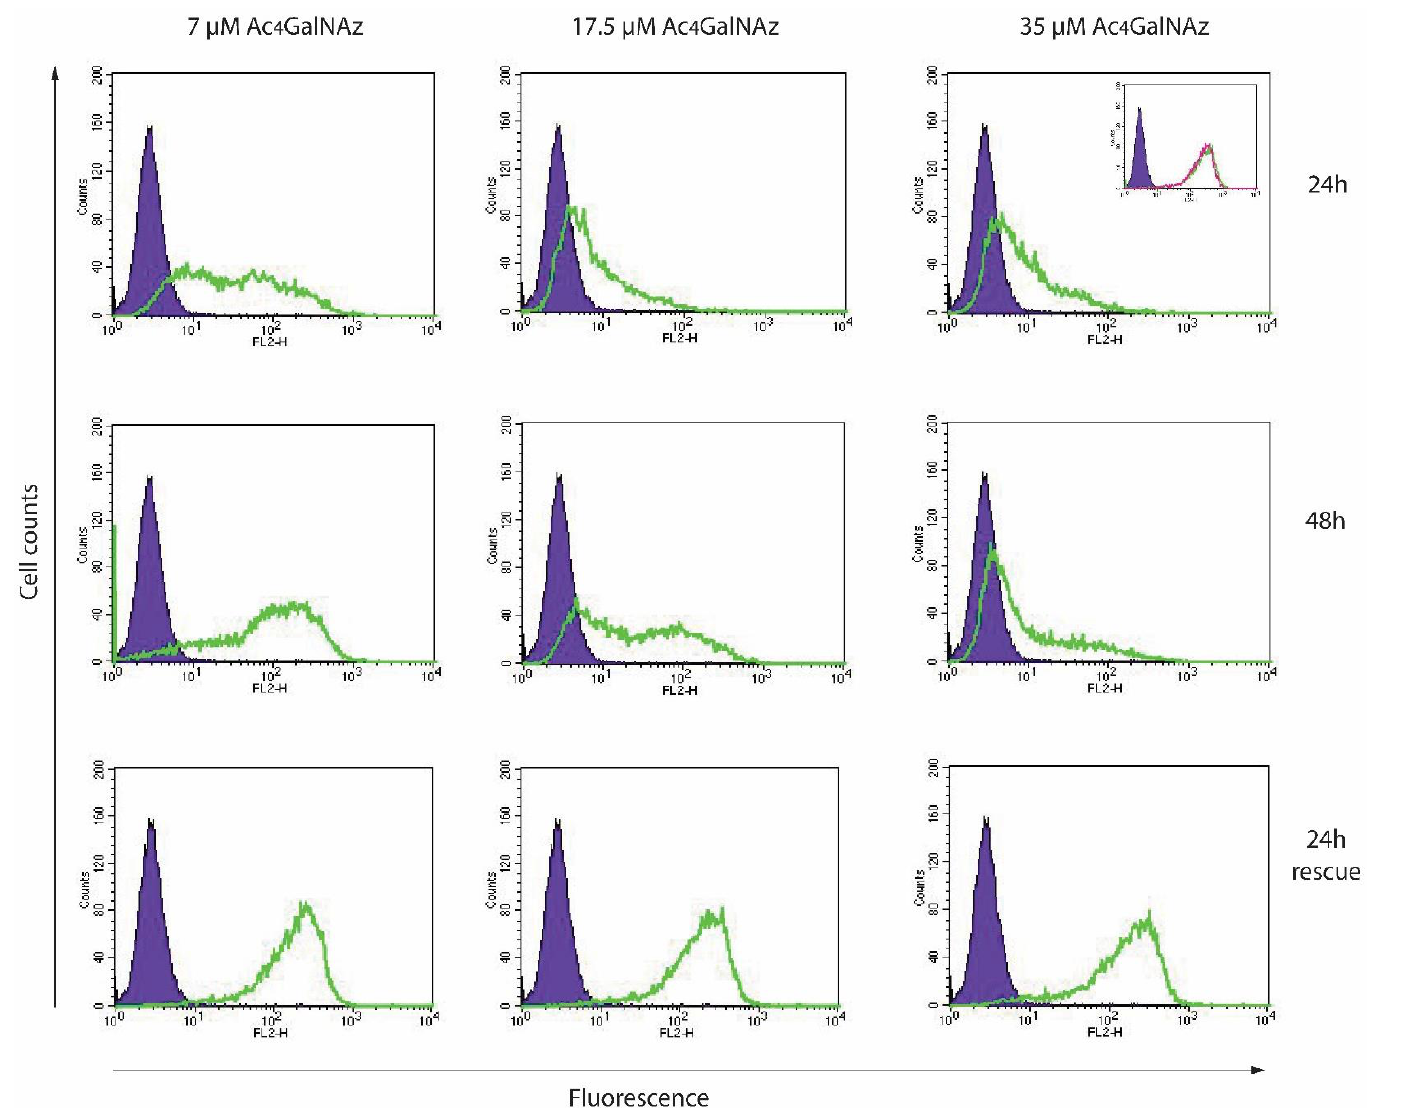
Figure 2. Flow cytometric analysis of Ac 4 GalNAz-treated CHOs. Cells were treated with 7 – 35 µM Ac 4 GalNAz for 24 – 48 h, or for the first 24 h, then 24 h without Ac 4 GalNAz (24 h rescue) and analysed for cell surface anti-HS (10E4) reactivity. Purple infilled, antibody control. Green trace, Ac 4 GalNAz-treated cells. Inset, experimental controls: purple infilled, antibody control; green trace, vehicle-treated; pink trace,